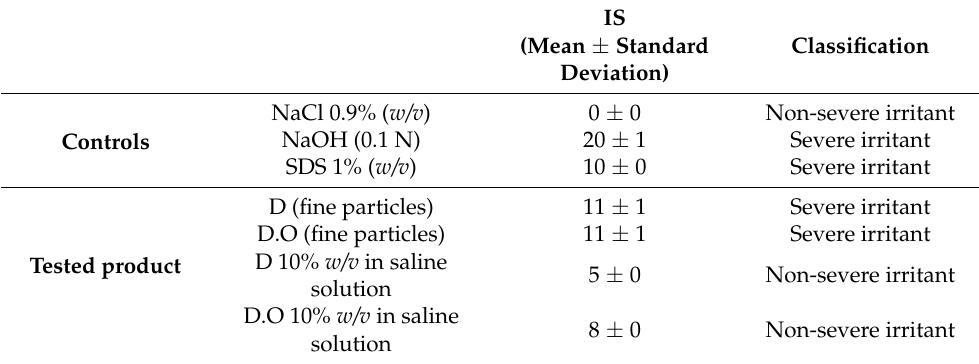
Table 5. Irritation Score and classification of samples. Results are presented as mean value ± standard deviation (SD), n =